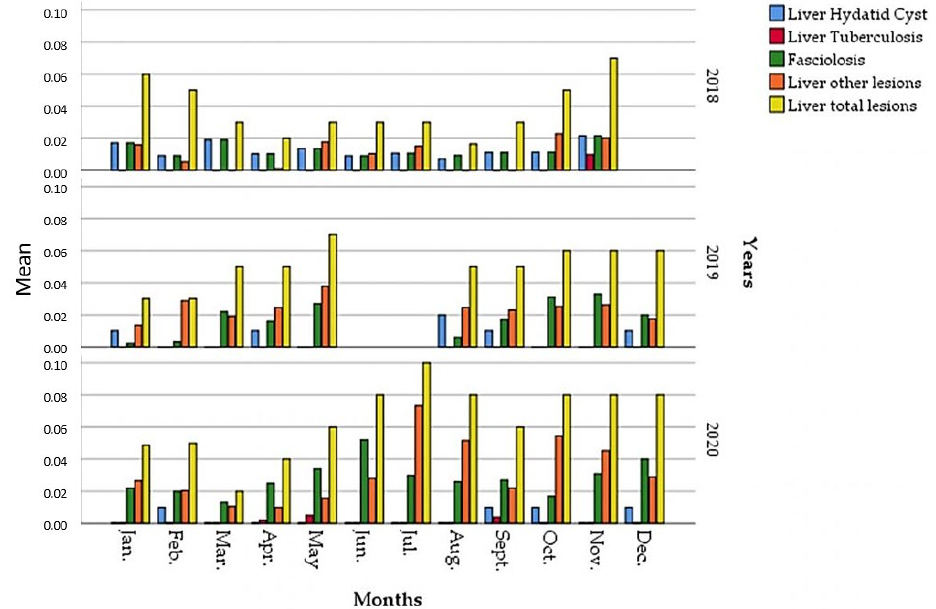
Figure 3. Monthly prevalences of the different liver seizures reasons during 2018, 2019 and 2020. In 2019, a high prevalence was recorded in May (7%) and November (6%). The highest prevalence of liver lesions (10%) was recorded in July 2020. In the same year, a second prevalence peak was observed in November (8%), which is not significantly higher than those recorded in previous years during the same period.